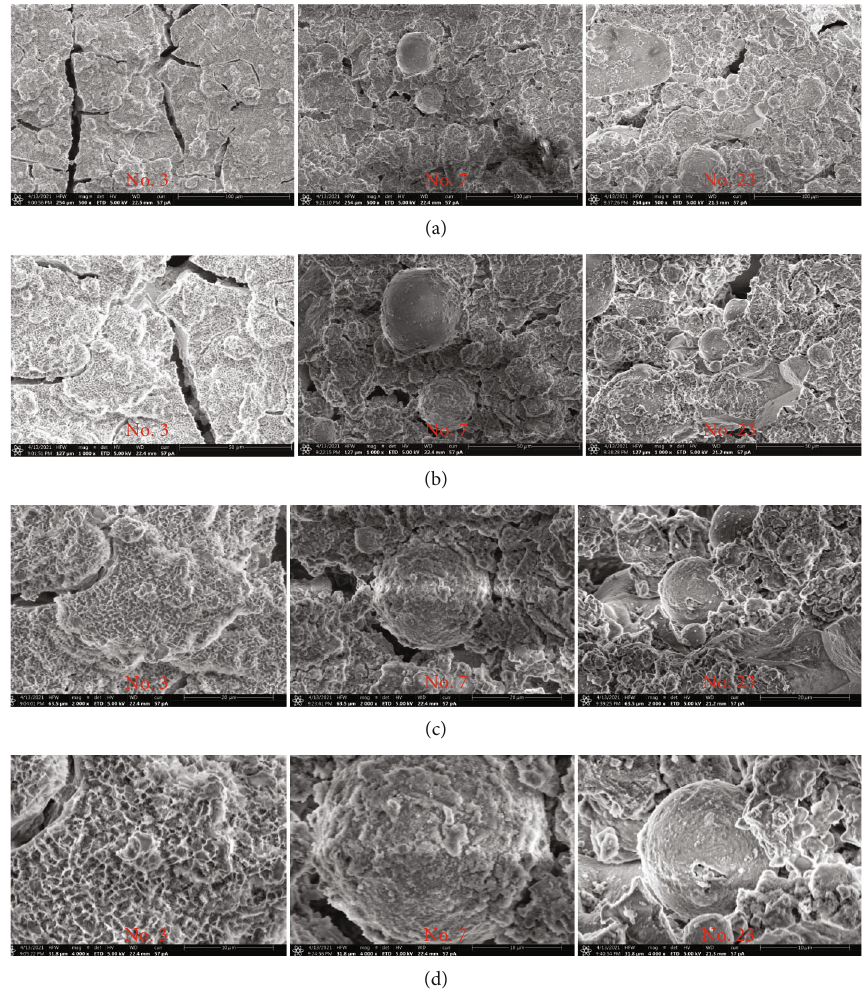
Figure 8: SEM images: (a) 500, (b) 1000, (c) 2000, and (d) 4000 times.